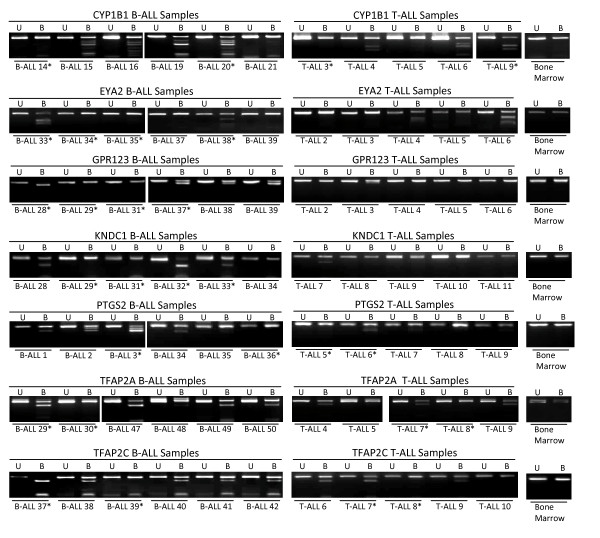
Methylation analysis in B and T-ALL. Representative combined bisulfite restriction analysis (COBRA) results for primary T-ALL and B-ALL samples and control bone marrow. No methylation was detected in any of the control bone marrow samples. U = undigested PCR product, B = BstUI digested PCR product. The samples labelled with * correspond to those ALL samples for which methylation was assessed by cloning and sequencing.